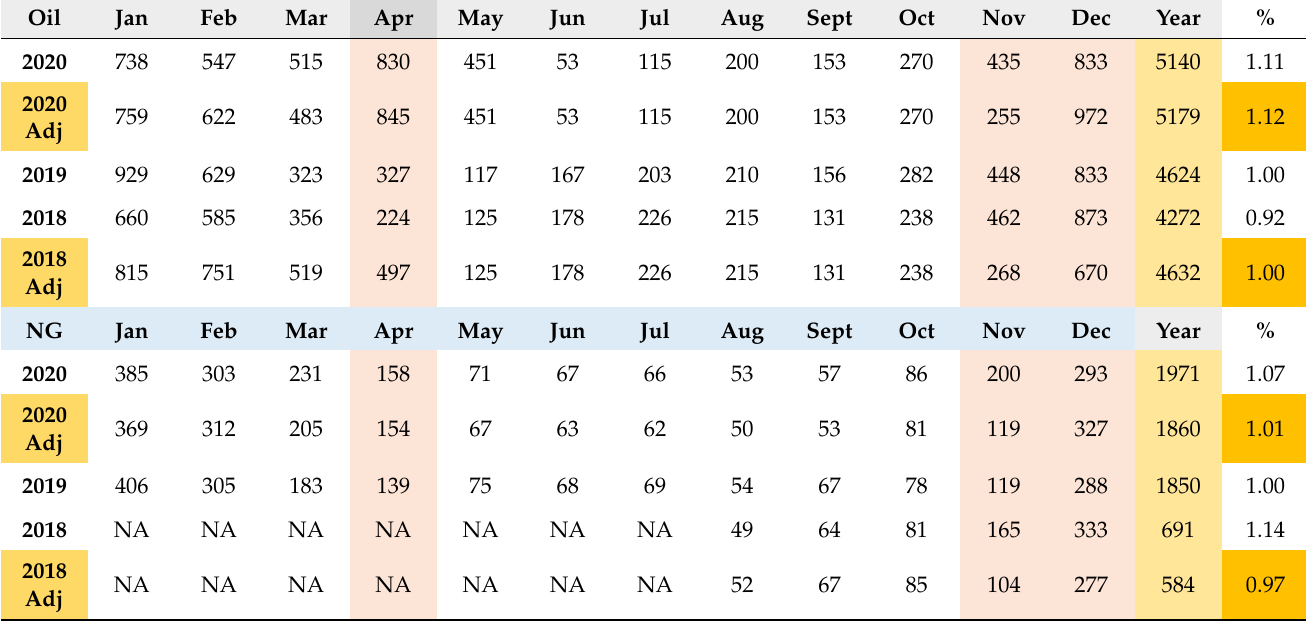
Table 8. Emissions from heating oil and NG in residential, tertiary, and industrial sectors (ktCO 2 ). Lockdown periods